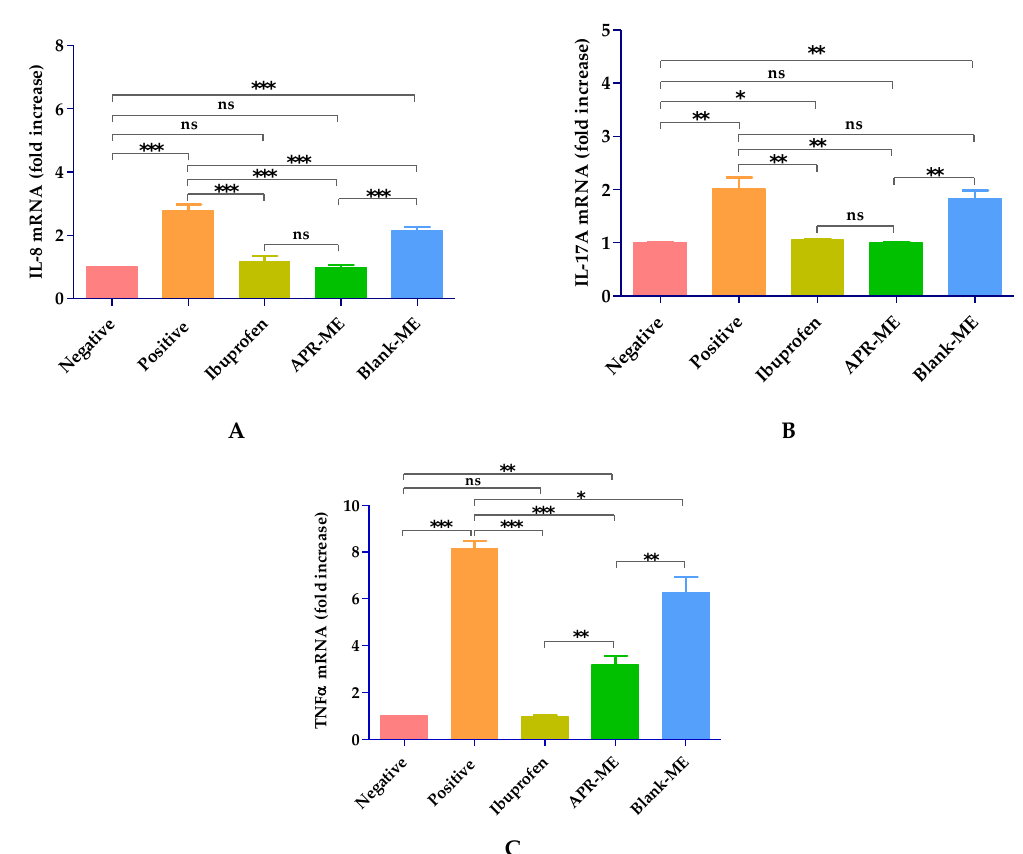
Figure 12. Relative expression of pro-inflammatory cytokines measured by RT-qPCR. ( A ) Interleukin-8 (IL-8); ( B ) Interleukin 17A (IL-17A); and ( C ) Tumor Necrosis Factor alpha (TNFα). Negative : untreated mice; Positive : AA-treated mice; Ibuprofen : mice treated with a reference anti-inflammatory product (ibuprofen gel); Blank-ME: mice treated with drug free vehicle; and APR-ME: mice treated with apremilast microemulsion. Results are expressed as mean ± SD ( n = 4). Statistically significant difference: *, p < 0.05; **, p < 0.01; ***, p < 0.001; ns, not significant.